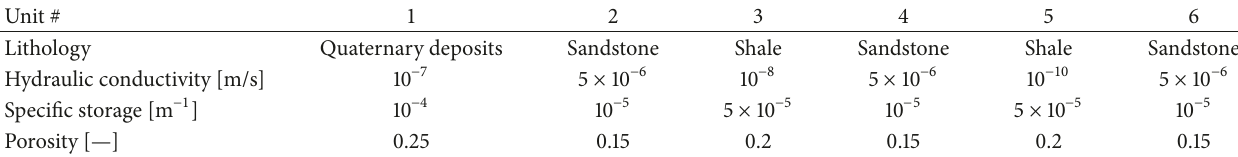
Table 2: Hydraulic properties of the hydrogeological units.